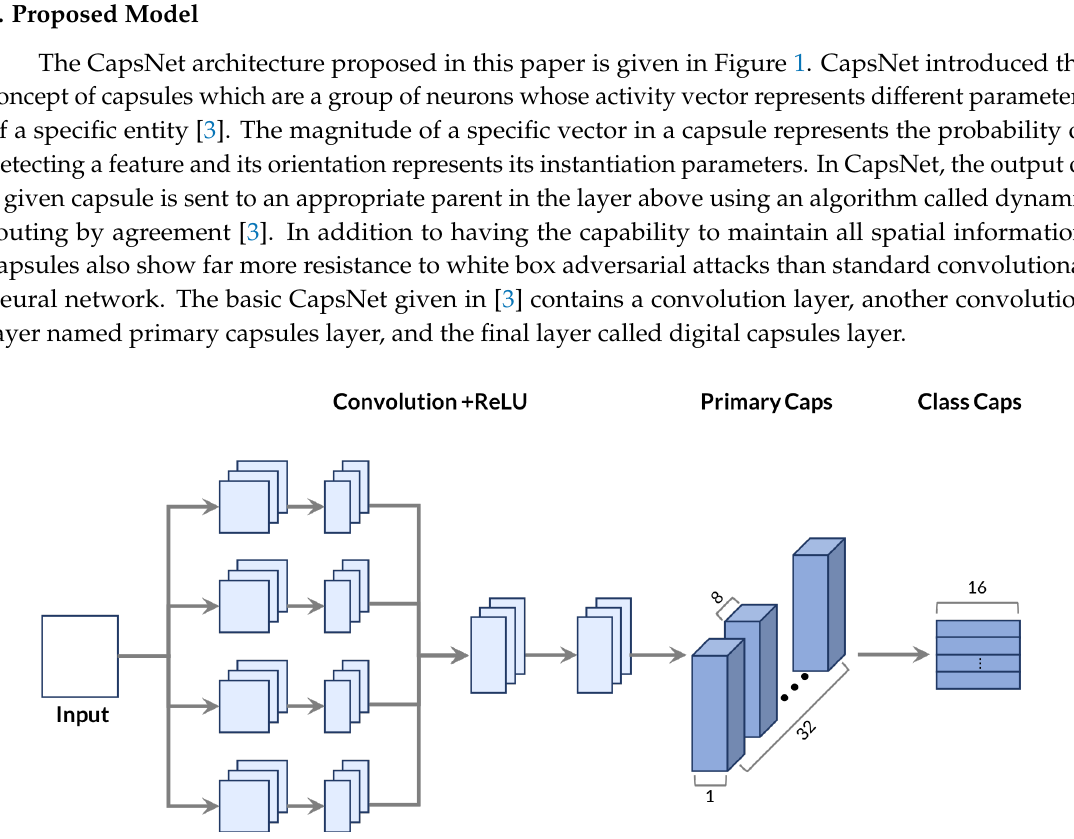
Figure 1. Proposed CapsNet architecture for sentence